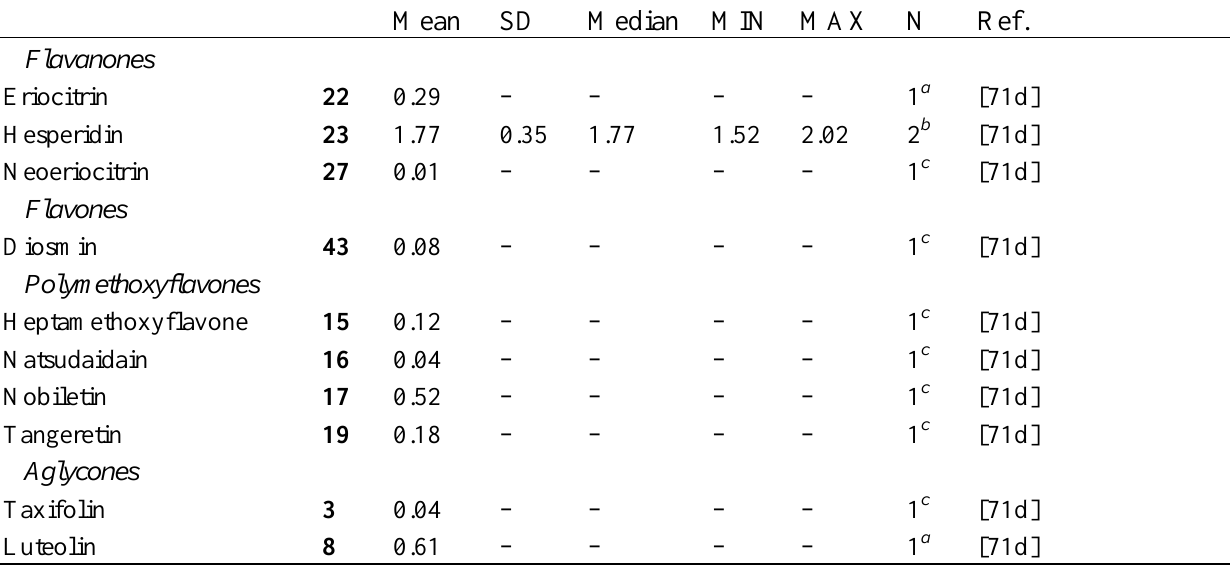
Table 14 . Flavonoid composition of C. aurantifolia juice (mg/100 mL).